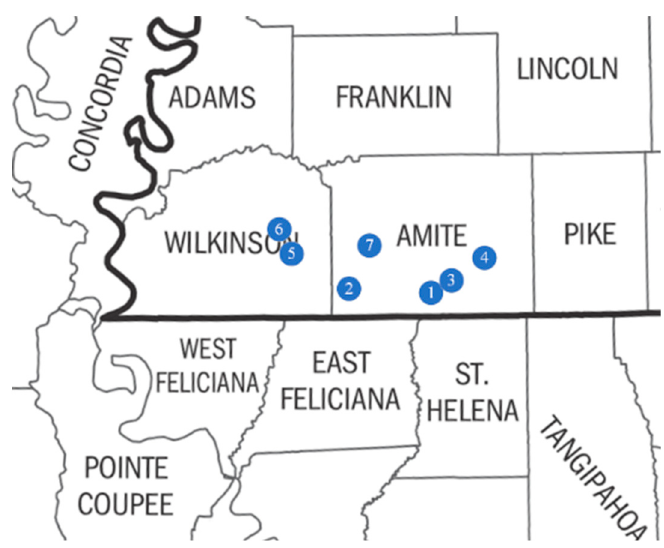
Figure 2. Map of the study area in Mississippi.